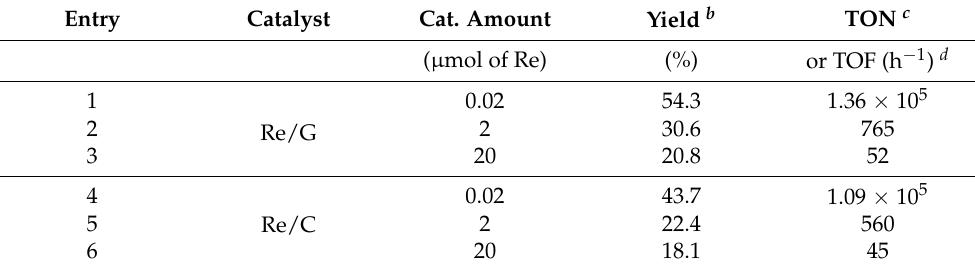
Table 3. MW-assisted oxidation of 1-phenylethanol in heterogeneous conditions (catalysed by Re/C or Re/G) a